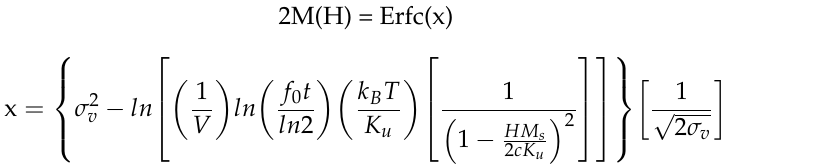
Figure 13. XPS spectra of FePtCAg/MgTiOBN film, ( a ) the metallic Fe, iron-oxide and iron-boride are indexed, ( b ) Pt and ( c ) C.